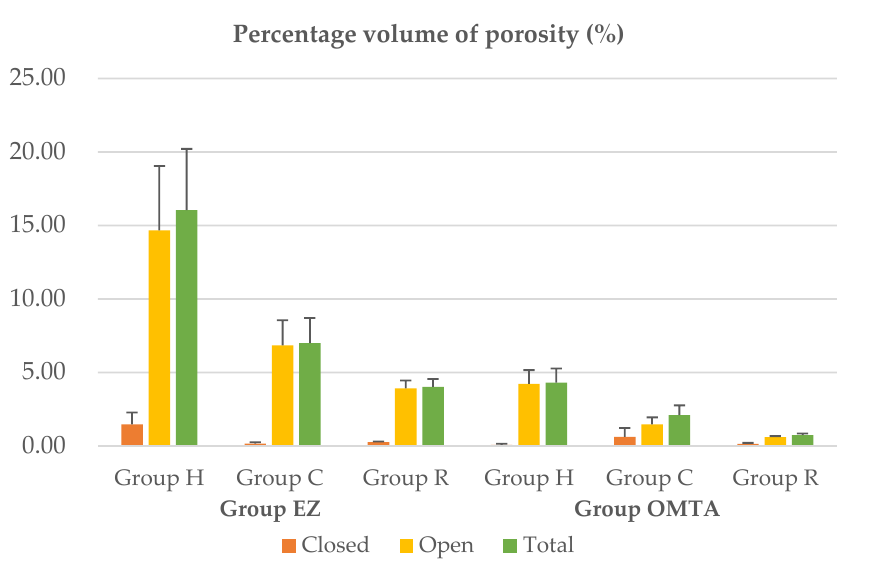
Figure 2. Percentage volume of closed, open and total porosity of each group. Table 3. Two-way ANOVA considering filling material, obturation technique, and their